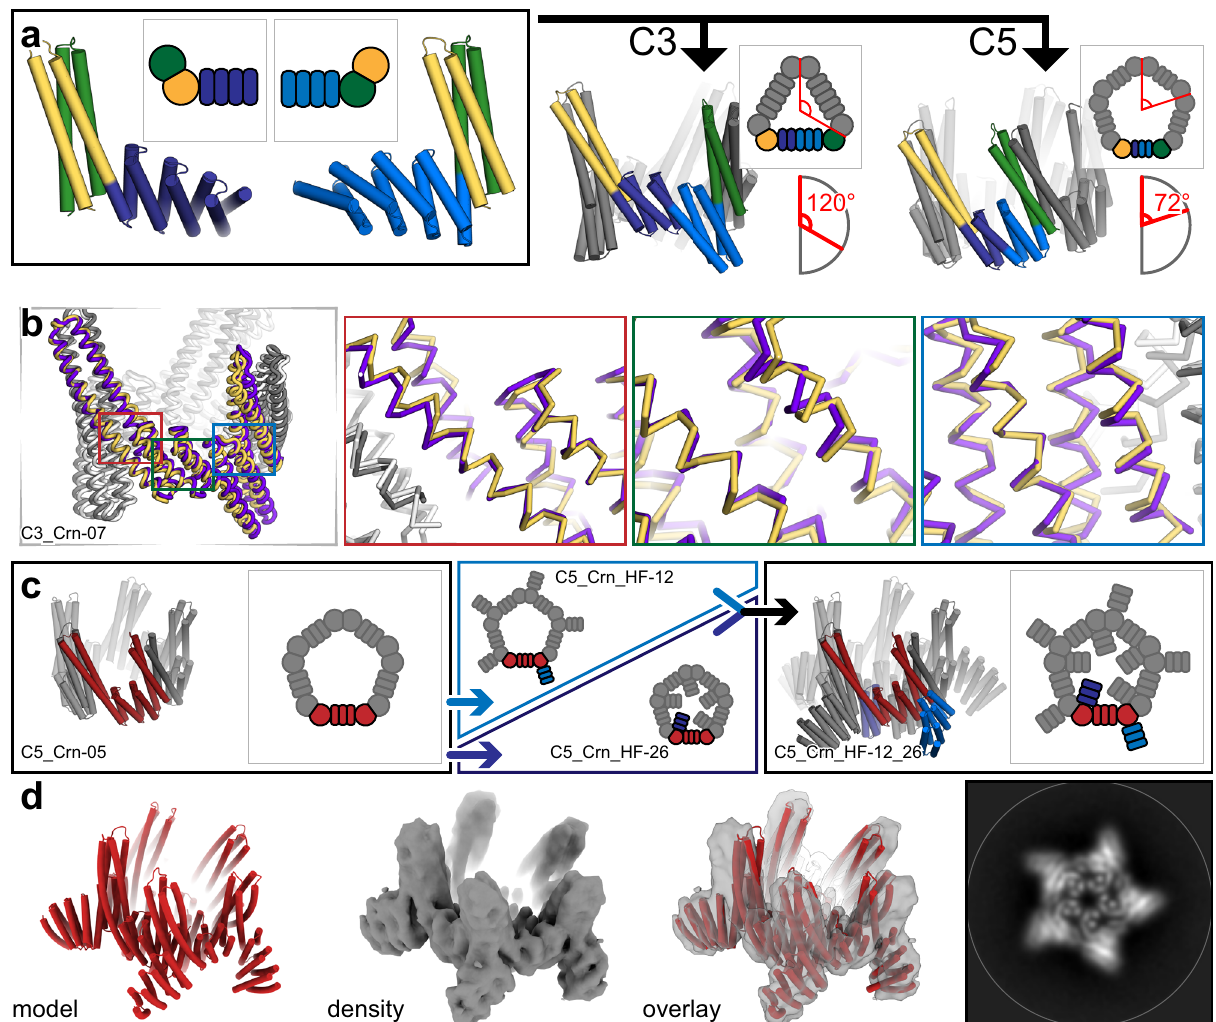
Fig. 3 Design of cyclic crowns from heterodimeric building blocks. a Hetero-dimeric HB (green/yellow) fused with different DHRs (shades of blue) were fused together using WORMS by enforcing a speci fi c overall cyclic symmetry (C3 and C5 shown). b The backbones of the crystal structure (yellow/white) of C3_Crn-05 overlaid with the design model (purple/gray). Insets show the backbone matching focused at each of the fusion locations. c A C5 crown (C5_Crn-07, asymmetric unit in red) was fused to DHR units on either outward facing ( “ C5_Crn_HF-12 ” , blue arrow) or inward facing termini ( “ C5_Crn_HF-26 ” , dark blue arrow). The two structures were then merged together to generate a double fusion ( “ C5_Crn_HF-12_26 ” , black arrow). d Cryo-EM class average of the fused 12_26 structure; the major C5 species shown. 3D reconstruction shows the main features of the designed structure are present, as is also evident in the class average